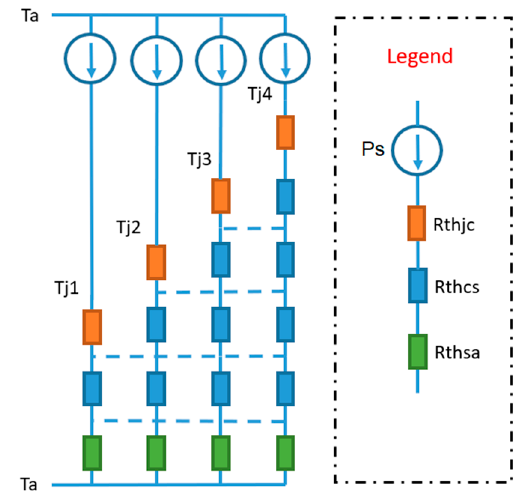
Figure 19. MSP thermal resistance 1D model.